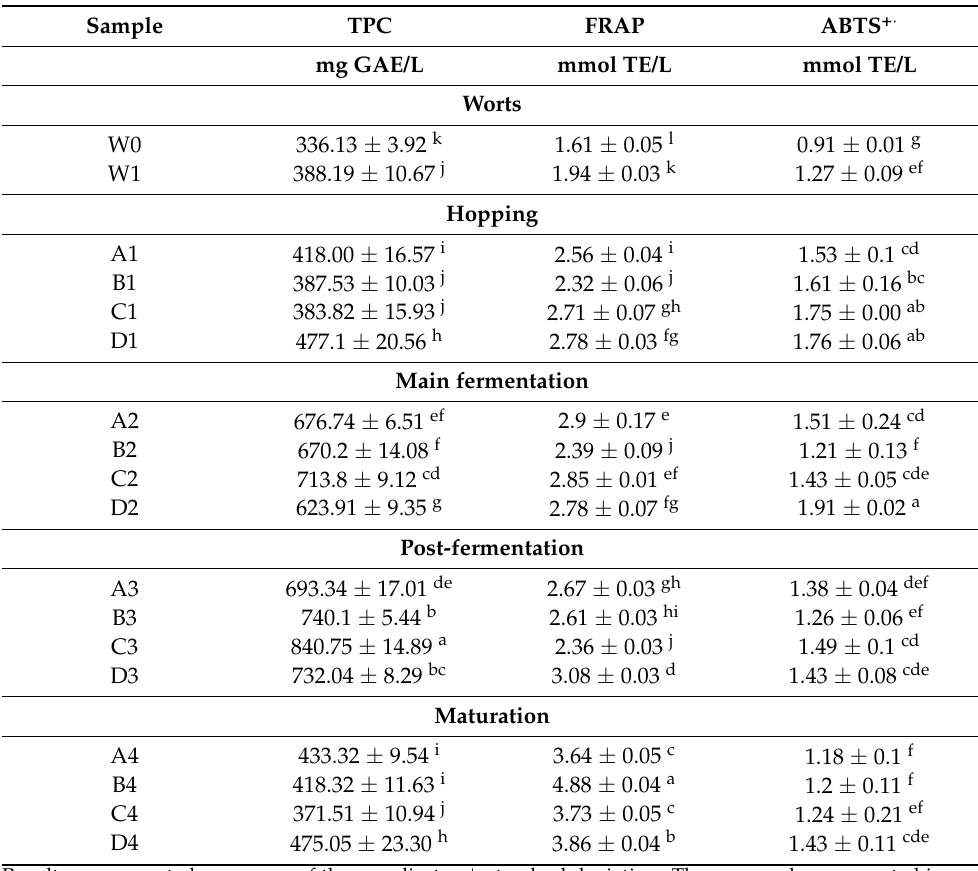
Table 5. The total content of polyphenolic compounds (TPC), the ability to reduce iron ions (FRAP), and the antioxidant capacity (ABTS • + ) of wort and beers at subsequent technological